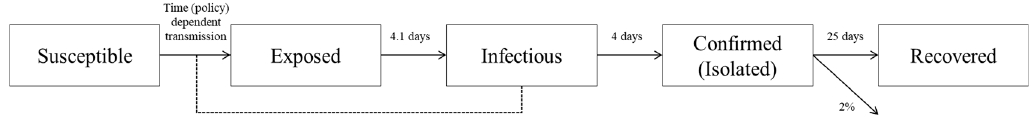
Figure 2. Flow diagram of COVID-19 transmission dynamics.